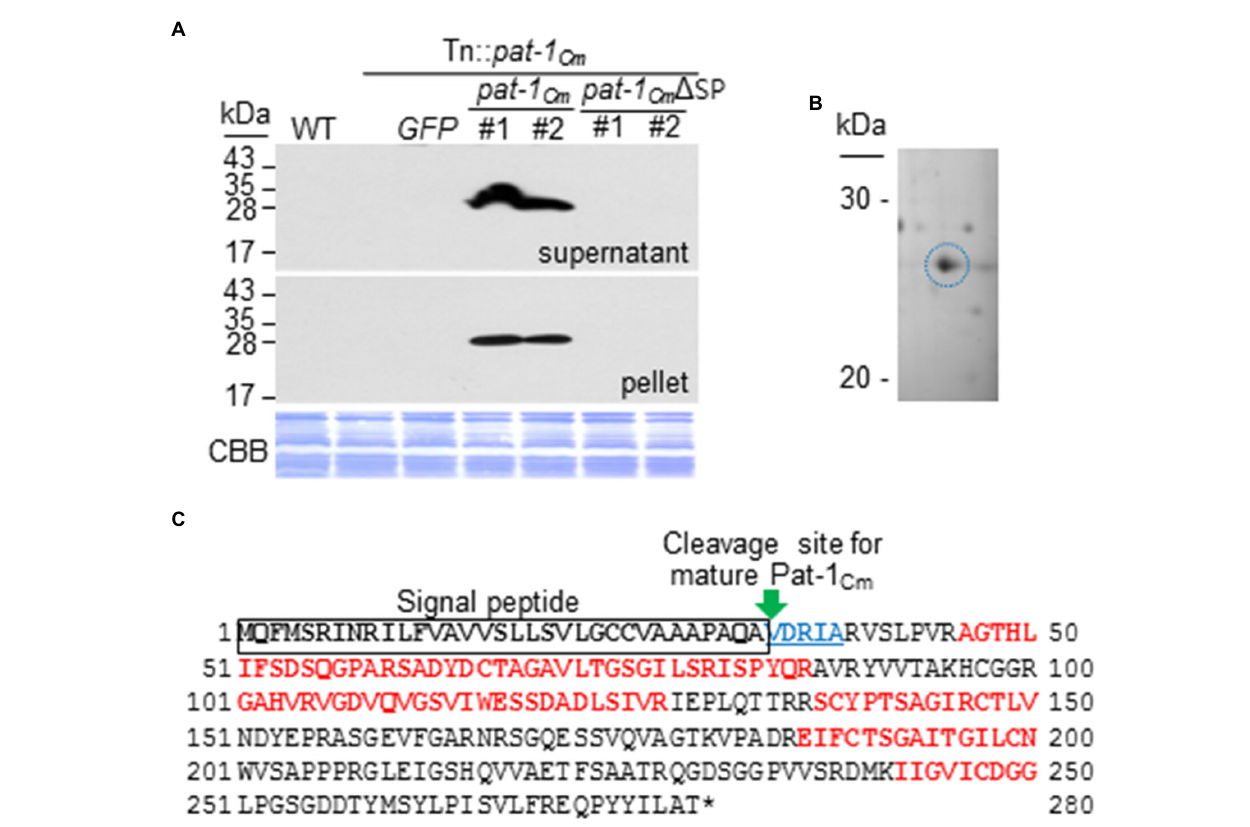
FIGURE 2 | Pat-1 Cm proteins are secreted and well-expressed in complementary strains. (A) Expression and secretion of Pat-1 Cm proteins in complemented strains by western blotting. Pat-1 Cm protein and its derivative were fused to FLAG on their C-termini and expressed in Tn:: pat-1 Cm strain. Total proteins from the supernatant and pellet were analyzed by immunoblotting using the FLAG antibody. CBB, Coomassie Brilliant Blue. Mock, 10 mM MgCl 2 ; WT, Clavibacter michiganensis LMG7333 wild type. (B) Pat-1 Cm proteins secreted in supernatant and separated by 2D gel. Pat-1 Cm protein spot (blue circle) was analyzed by mass spectrometry (see Supplementary Figure 2C ). (C) Identification of Pat-1 Cm proteins by 2D-LC MS/MS. Red bolded letters indicate peptide sequences obtained from mass spectrometry. Black bolded letters indicate predicted SP sequence. Five blue bolded underlined letters indicate N-terminal sequences of mature Pat-1 Cm obtained by Edman